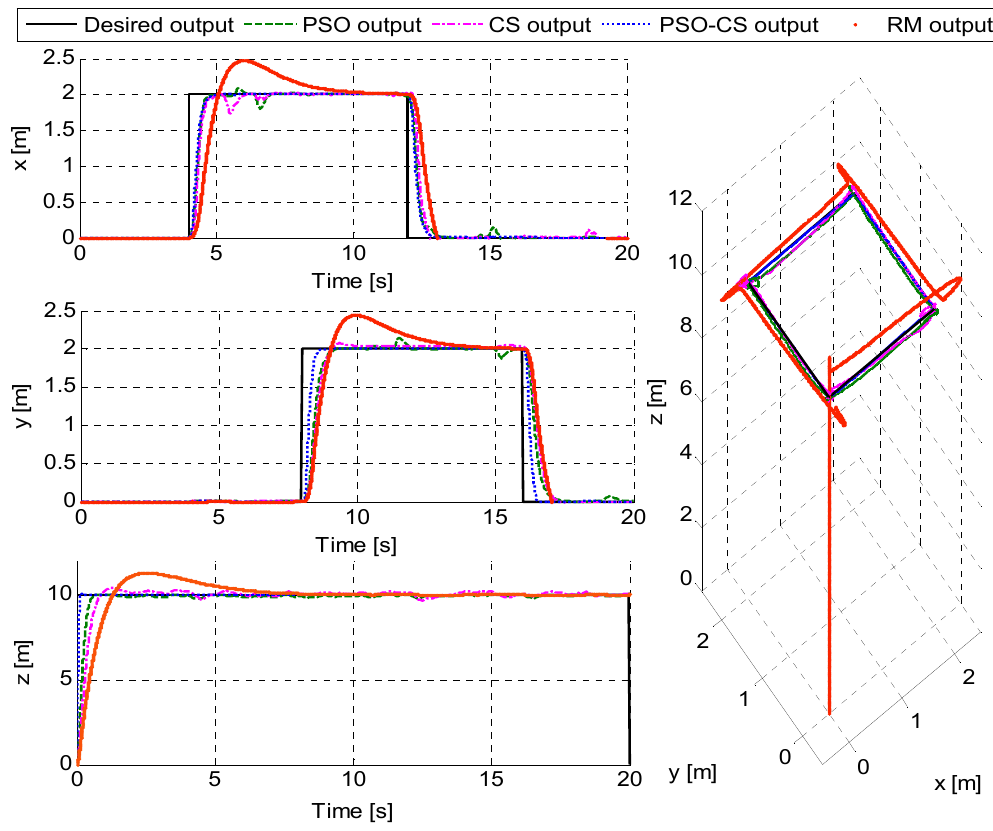
Figure 12. Quadrotor’s positions ( x , y , z ) using Particle Swarm Optimization (PSO), Cuckoo Search (CS), Particle Swarm Optimization-Cuckoo Search (PSO-CS), and Reference Model (RM) with disturbance (rectangular trajectory).